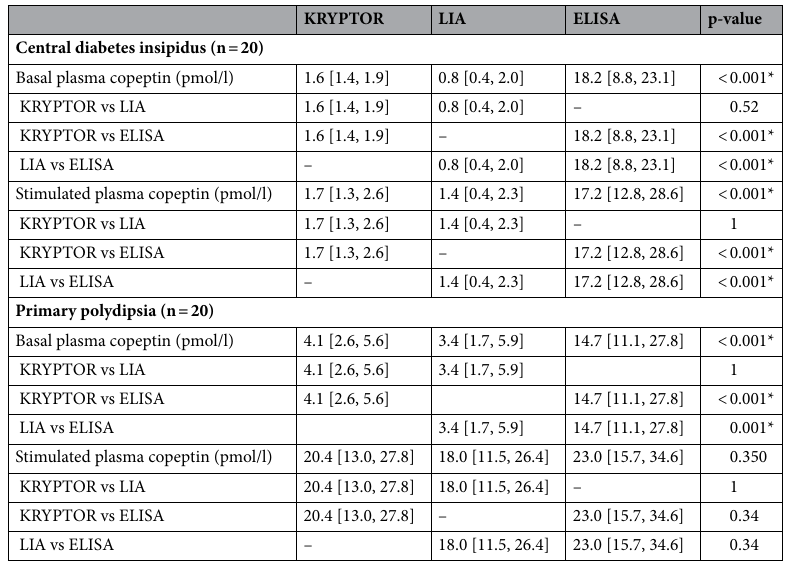
Table 3. Basal and stimulated copeptin concentrations of patients with central diabetes insipidus and primary polydipsia upon the hypertonic saline infusion test. Copeptin was measured in duplicates with the KRYPTOR, the LIA and the ELISA. Results are indicated as median [Interquartile range]. Three-group comparison was done using the Friedman Test. Posthoc two group comparison was done using the paired Wilcoxon Sign Rank Test with Bonferroni p-value adjustment. *Statistically significant.